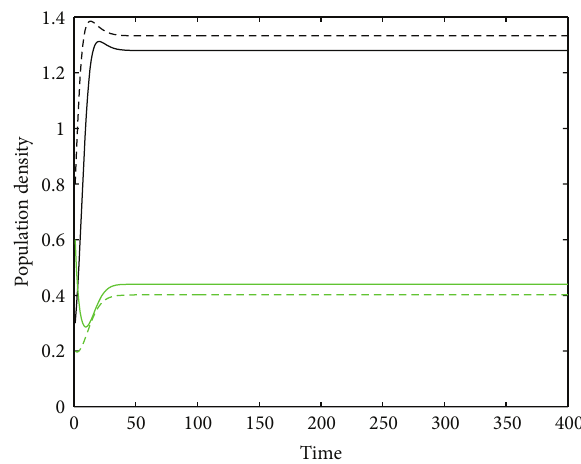
Figure 1: Permanence of model (30). The black solid (dotted) line is the population variation of the prey in patch 1 (patch 2). The green solid(dotted)lineisthepopulationvariationofthepredatorinpatch 1 (patch